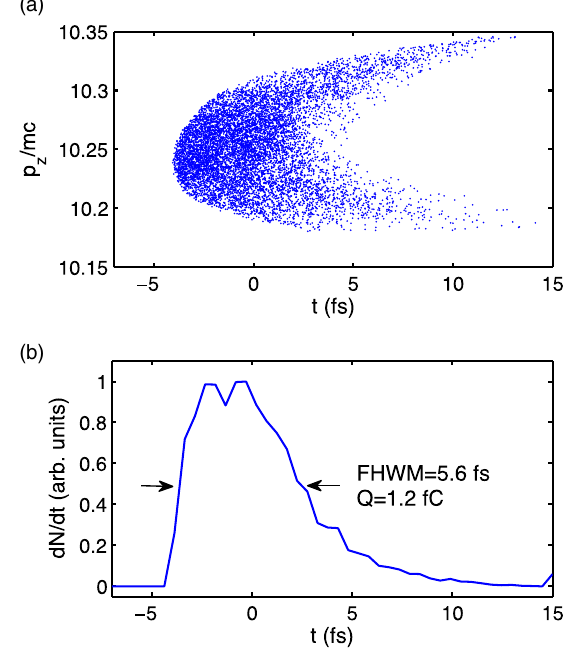
FIG. 7. Results of GPT simulations using the electron distri- bution from the PIC simulations. (a) Electron distribution in phase space ð p z ; t Þ for the compressed bunch in the sample